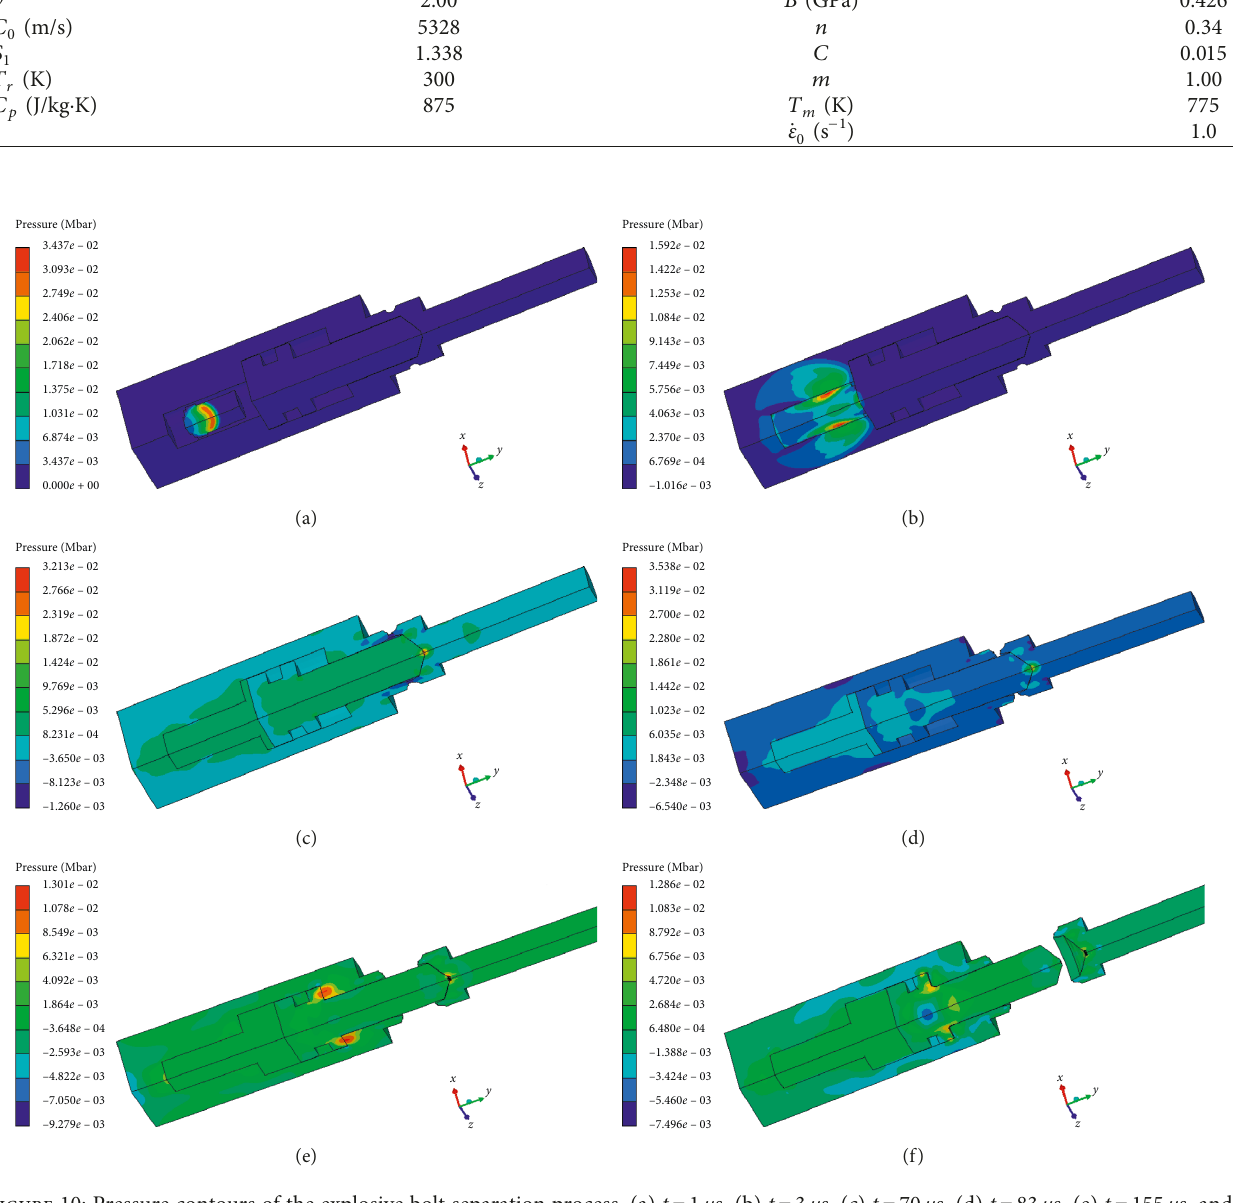
Figure 10: Pressure contours of the explosive bolt separation process. (a) t � 1 μ s, (b) t � 3 μ s, (c) t � 70 μ s, (d) t � 83 μ s, (e) t � 155 μ s, and (f) t � 200 μ